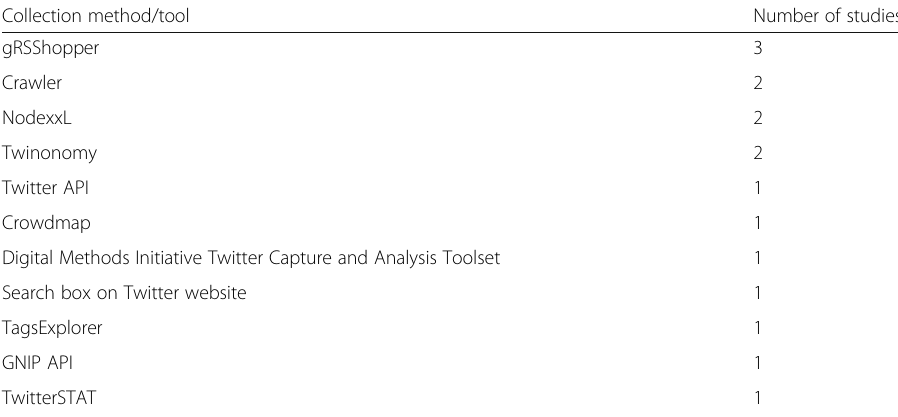
Table 2 Tweet Data and Metadata Collection Methods/Tools Collection